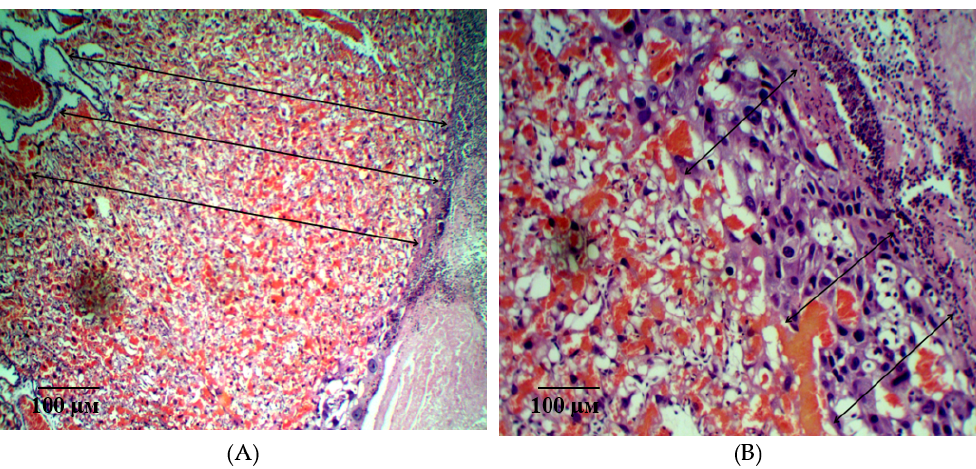
Figure 12. Measurement of the thickness of the fetal ( A ) and maternal ( B ) parts of the placenta on the 21st day of gestation in animals with ADMA-like preeclampsia when pHBSP was administered at the dose of 250 µg/kg. Note: Hematoxylin and eosin staining. Magnification: 200×. In addition, there was a partial restore of the cellular density of the placental tissue component of the maternal and fetal placenta and the diameter of the villi (Table 2). Table 2. The effect of pHBSP on the cell pool density in the fetal and maternal placenta and the villi diameter in experimental preeclampsia (М ± SD, n = 10 animals in each group).